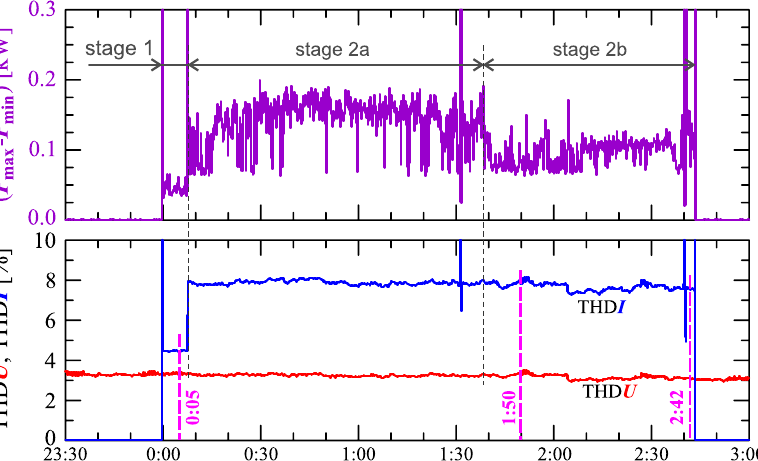
Figure 17. The difference between the maximum and minimum active power ( P max − P min ) = f ( t ) (top), the voltage THD factor THD U = f ( t ) , and current THD factor THD I = f ( t ) (bottom) with the markings of measurement results presented on the waveforms (Figure 21) and amplitude spectra (Figure 20) recorded at 0:05, 1:50, and 2:42 for Case